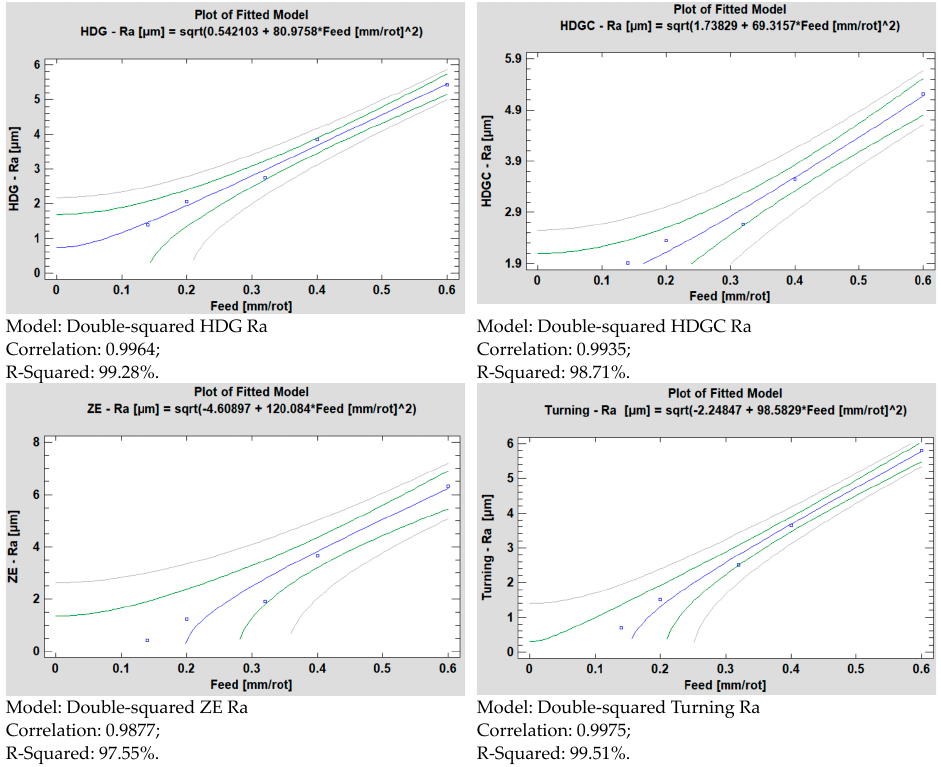
Figure 17. Plot of fi tt ed model for the R a variation according to the turning technology.